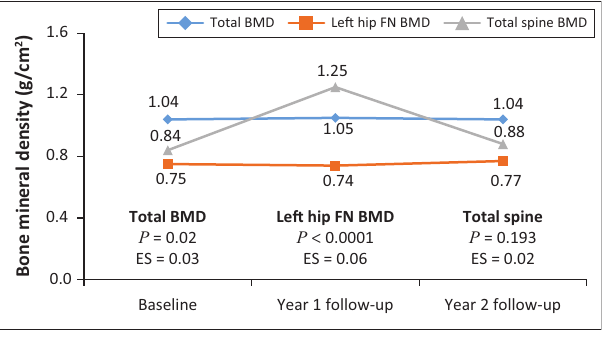
FIGURE 2: Bone mineral density changes over 2 years from